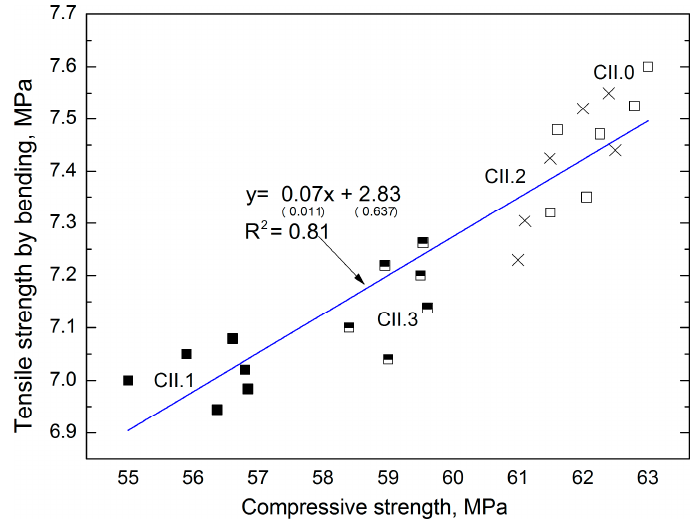
Figure 8. Dependence between the compressive strength and tensile strength in bending of CII concrete.